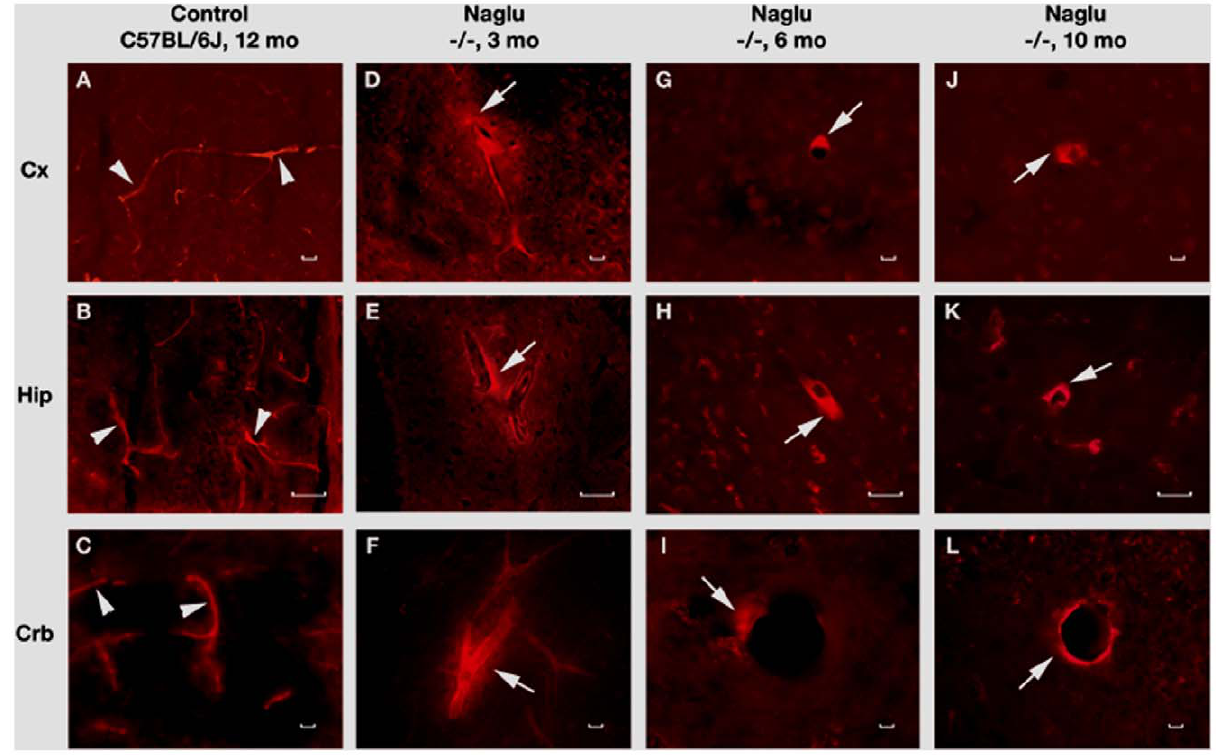
Figure 5. Evans Blue (EB) fluorescence in the brains of Naglu mice. In the brain, EB can be clearly detected within the blood vessels ( A , B , C , red, arrowheads) in the control C57 BL/6J mouse at 12 months of age. In Naglu mice, vascular leakage of EB (red, arrows) is visible in various brain structures ( D , E , F ) at early (3 months of age), ( J , H , I ) at late (6 months of age), and ( J , K , L ) at end stage of disease (10 months of age). Significant EB diffusion into the brain parenchyma from many blood vessels can be detected in end-stage Naglu mouse (10–12 months of age). Cx – cerebral cortex, Hip – hippocampus, Crb – cerebellum. Scale bar in A through L is 25 m m.